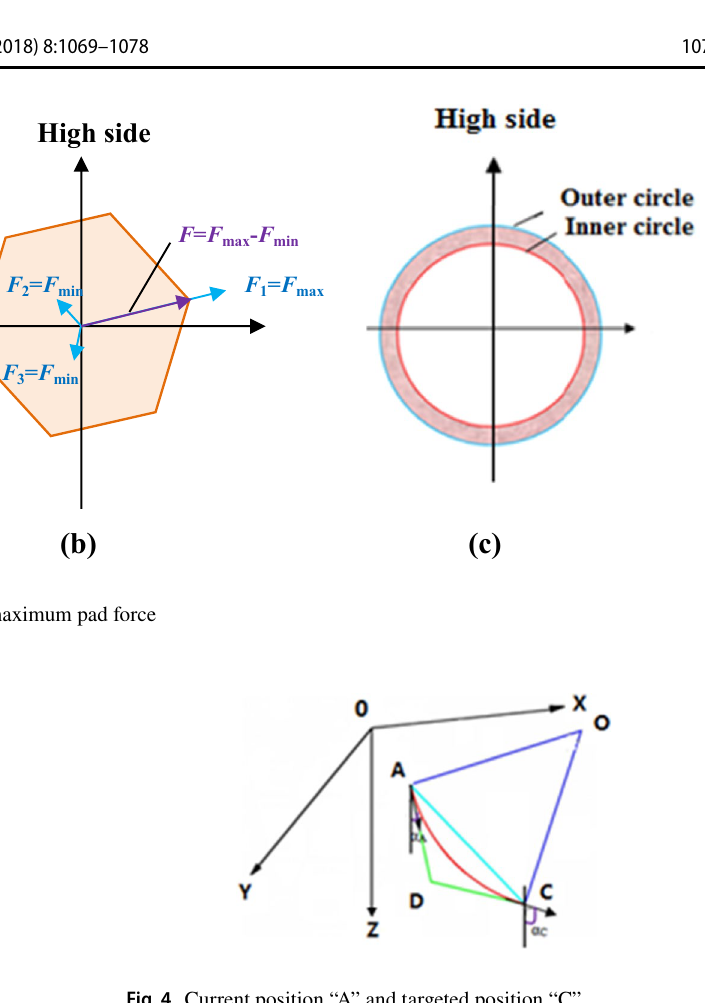
Fig. 4 Current position “A” and targeted position